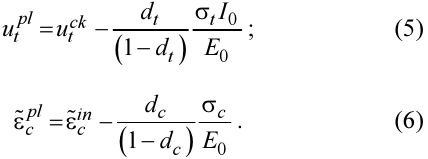
Fig. 5. Biaxial yield surface of concrete in CDP Model (Lubli- ner et al.